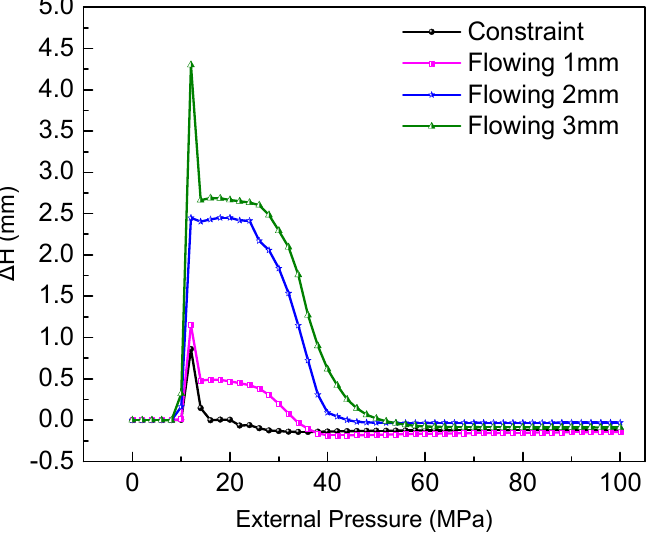
Figure 16. Variation of ∆H under different material flowing displacements.